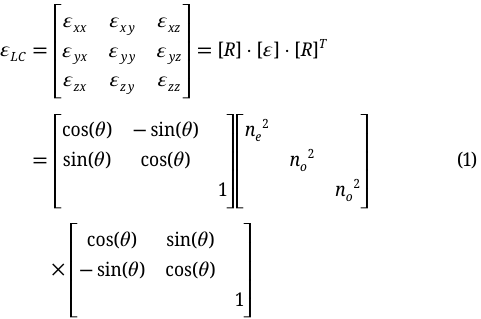
Figure 1: Schematic of the TMC. (a) Schematic of the TMC covered by LC, the TE input waveguide to the 2 μ m wide output waveguide. (b) The incident TE along the x -axis, converted to the TE is perpendicular to the x